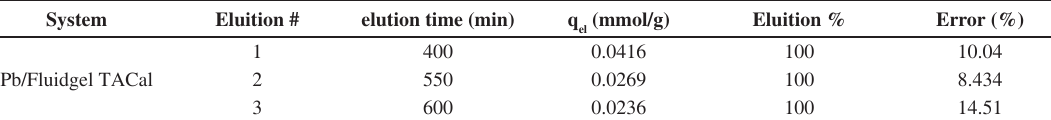
Table 4. Parameters regeneration of the columns with CaCl